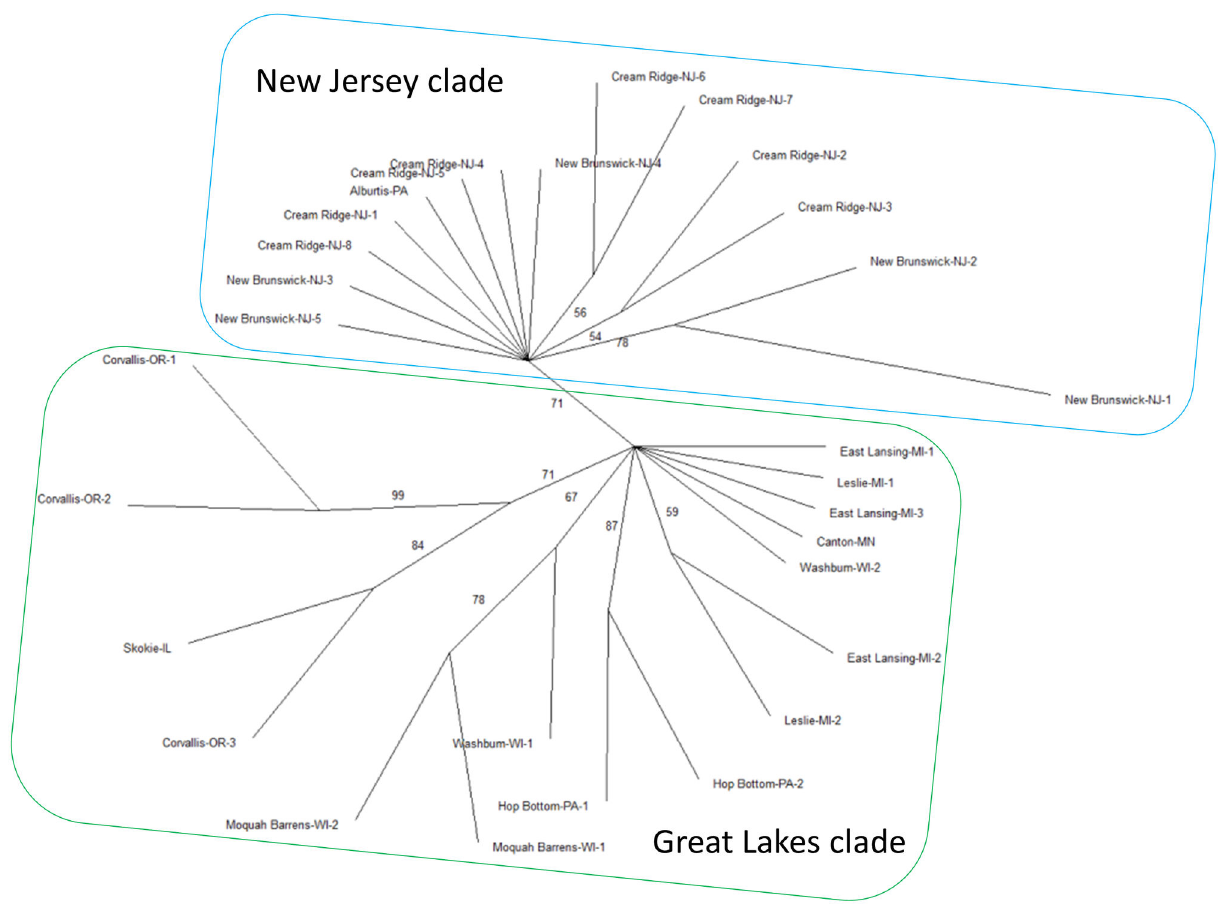
Figure 6. Consensus UPGMA tree of 30 Anisogramma anomala isolates characterized by 10 microsatellite loci. Isolates are named by the city and state from where they were collected, and followed by a number if multiple isolates were obtained from the same location. Isolates were grouped into two clades in accordance with their geographic origins. UPGMA trees were generated by PowerMarker version 3.25 [36] using frequency-based genetic distance of shared alleles [39]. Consensus tree was computed